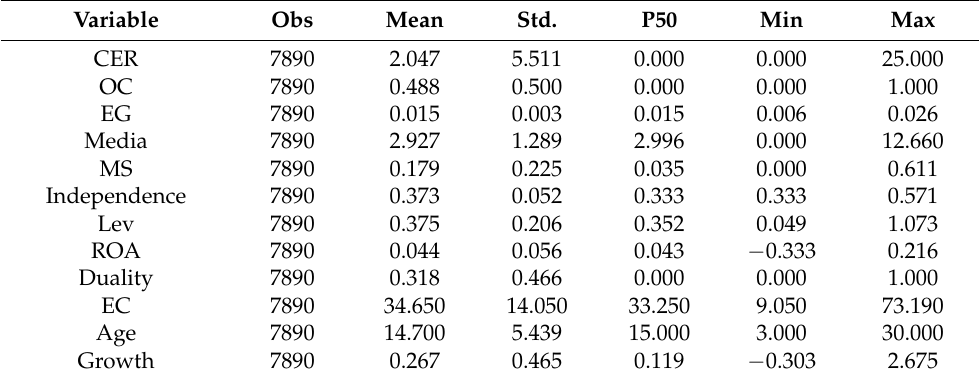
Table 2. Summary of descriptive statistics.